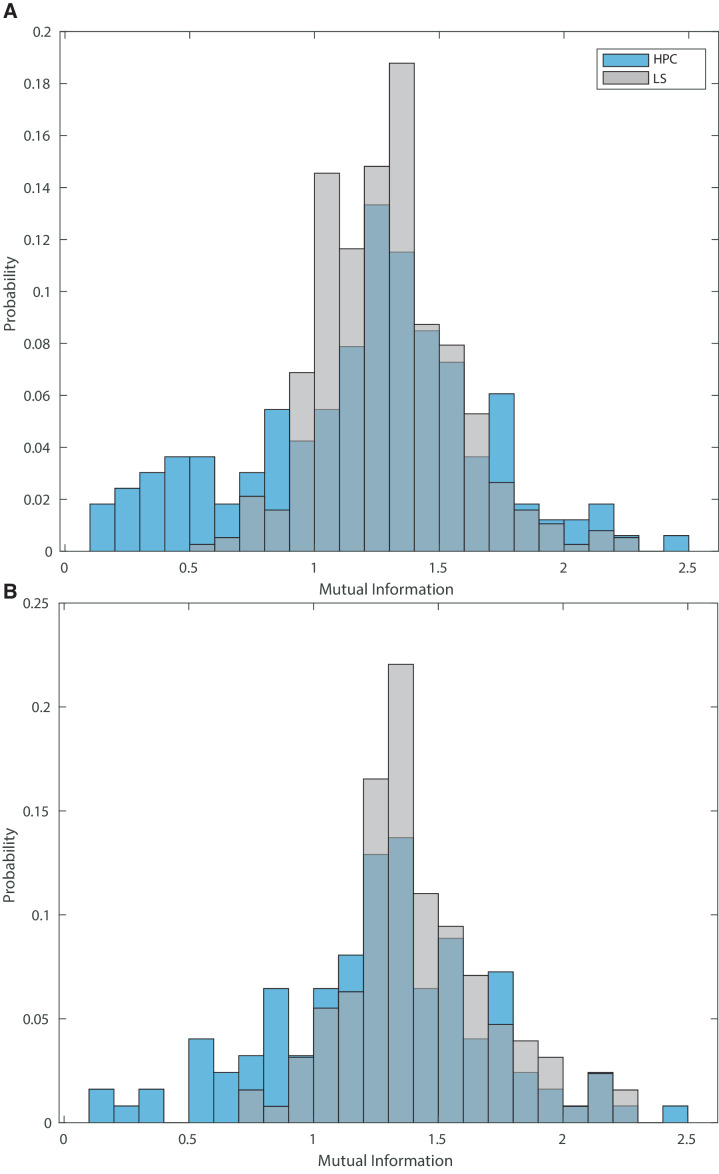
Mutual information in HPC and LS cells.(A) Mutual information for all cells. Mean mutual information in the hippocampus is 1.20+−0.47, while mutual information in the septum is 1.29+−0.23. These values are significantly different (double sided t-test t(541)=-3.05, p<.005). Many LS cells without a place field may have a high mutual information score due to spatial correlations with speed and acceleration (Wirtshafter and Wilson, 2019). (B) Mutual information for cells with spikes/bit greater than or equal to 0.8. Mean mutual information for these cells in the hippocampus is 1.27+−0.44, while mutual information in the septum is 1.43+−0.30. These values are significantly different (double sided t-test t(249)=-3.35, p<.005).